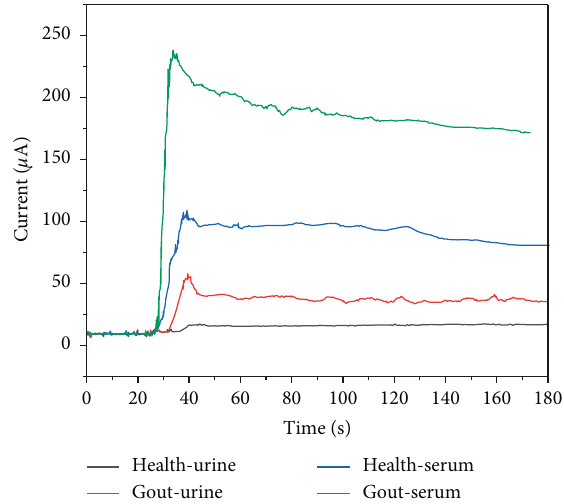
Figure 7: Amperometric response recorded using CuNW/SPCE towards urine samples and serum samples from healthy person and gout